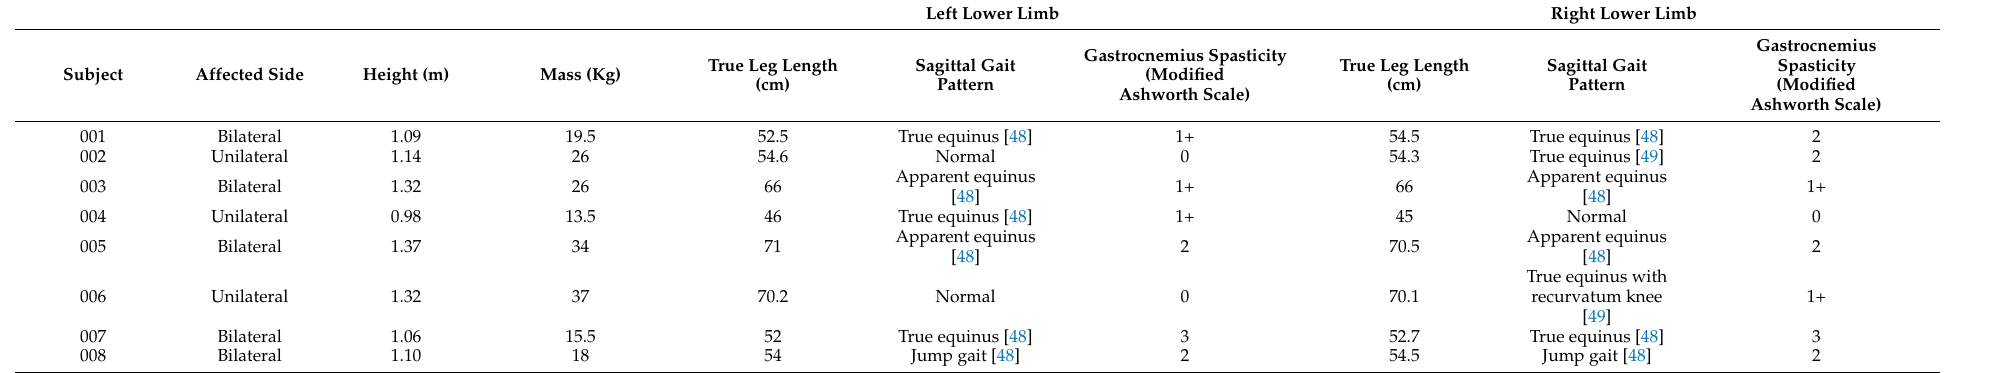
Table 1. Subject characteristics.